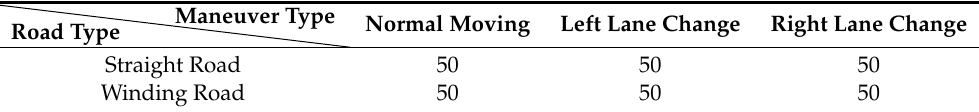
Table 2. Data used in the training process.